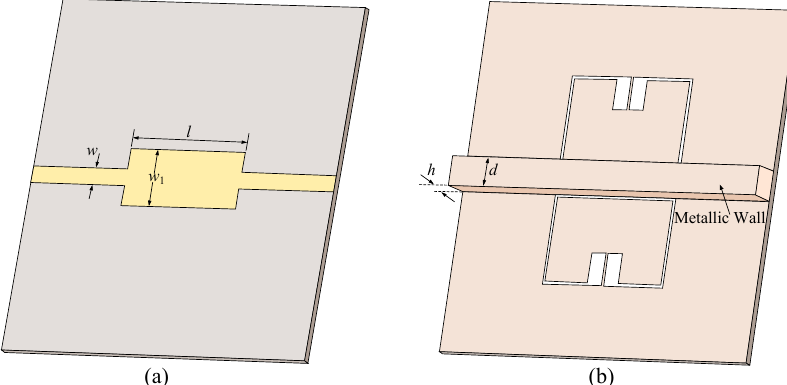
Figure 4. The designed differential sensor using a metallic wall separating the two halves of a MLC resonator. ( a ) Front view of the sensor. ( b ) Back view of the sensor. All the dimensions are the same as Figure 1 except w 1 = 4.2 mm and e = 2.2 mm here. In addition, d = 2.2 mm and h = 2 mm.